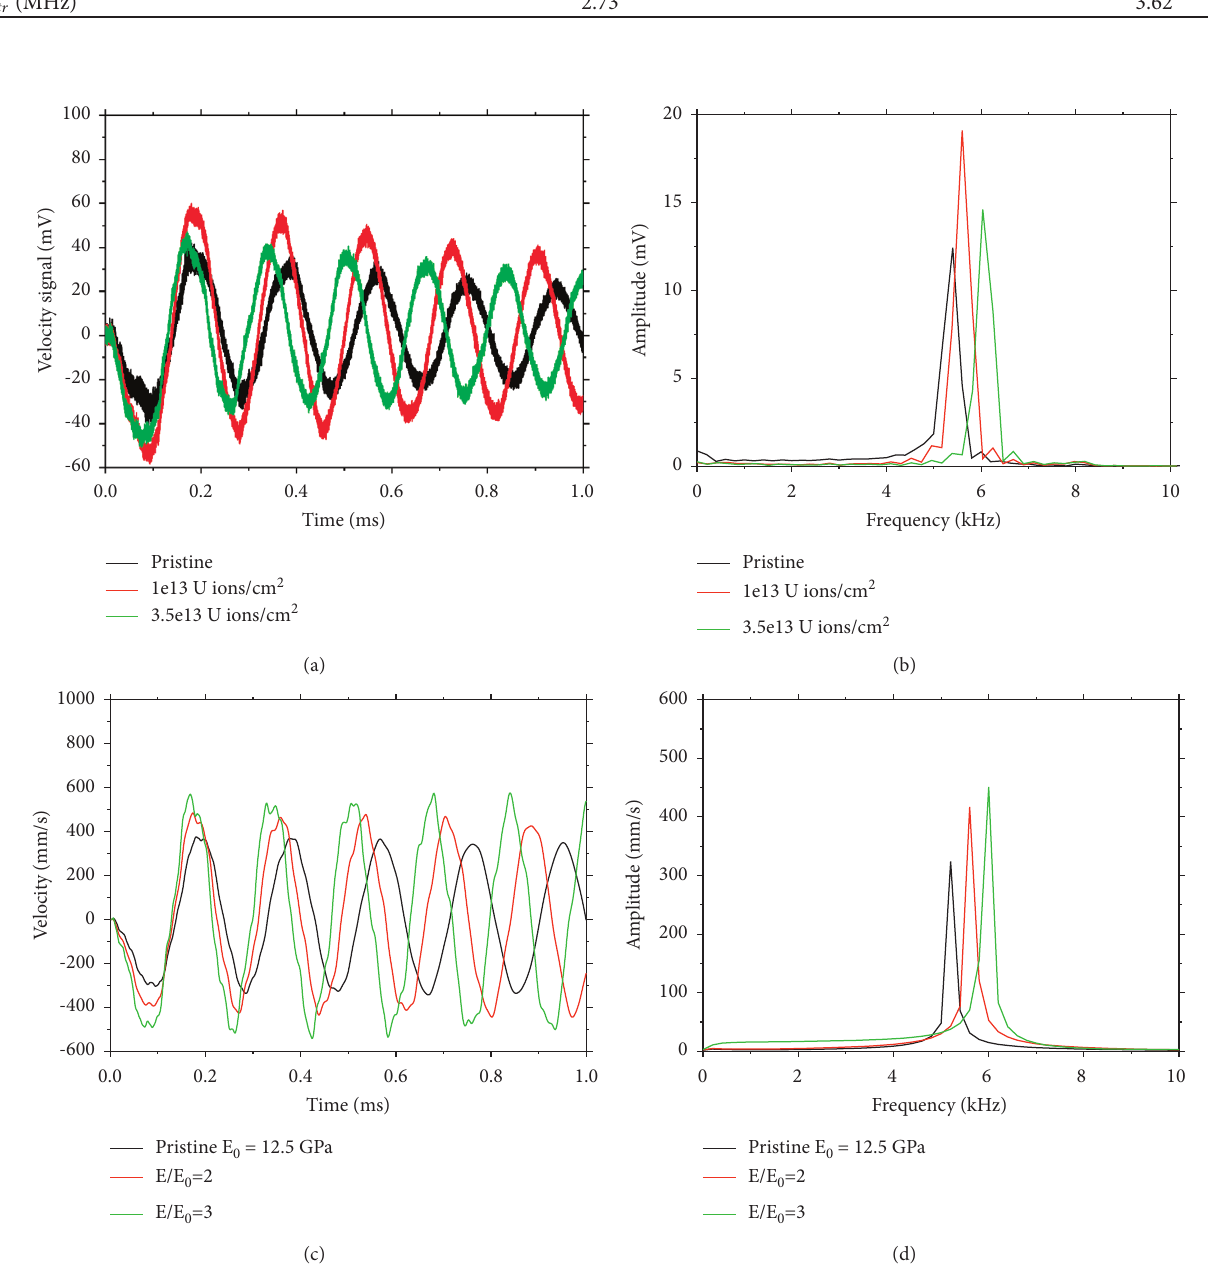
Figure 5: (a) Time-dependent velocity signal measured by LDV and (b) corresponding FFTspectra at the rear side ( x � y ≈ 0, z � 0.5) of a free 0.5mm-thick isotropic SGL R6650 graphite disc for the irradiation with 1.14GeV U-ions at different fluences. Corresponding ANSYS simulations at x � y � 0, z � 0.5: (c) time-dependent velocity and (d) FFT spectra for the impact of a 100 μ s U-ion pulse (power density: 3MW/cm3). Depicted are simulations of a pristine sample and samples with values of Young modulus 2 and 3 times higher than the pristine value as well as thermal conductivity degradation from 95W/m · K (pristine graphite) to 11W/m · K and 4 W/m · K, respectively [26], in the heated volume.